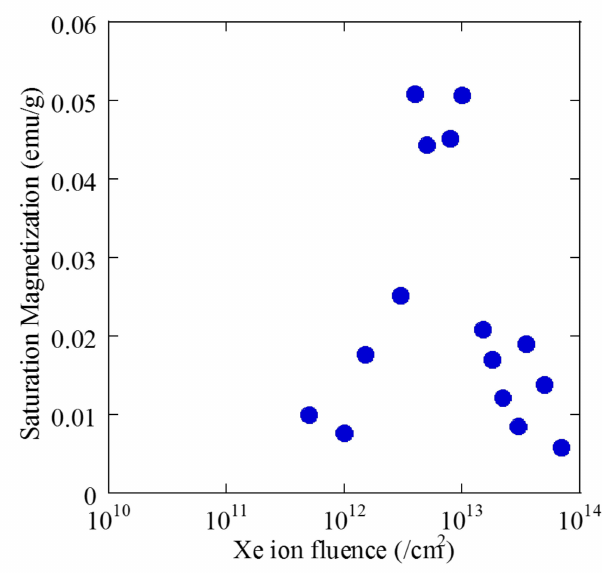
Figure 5. Saturation magnetization of CeO 2 as a function of Xe ion